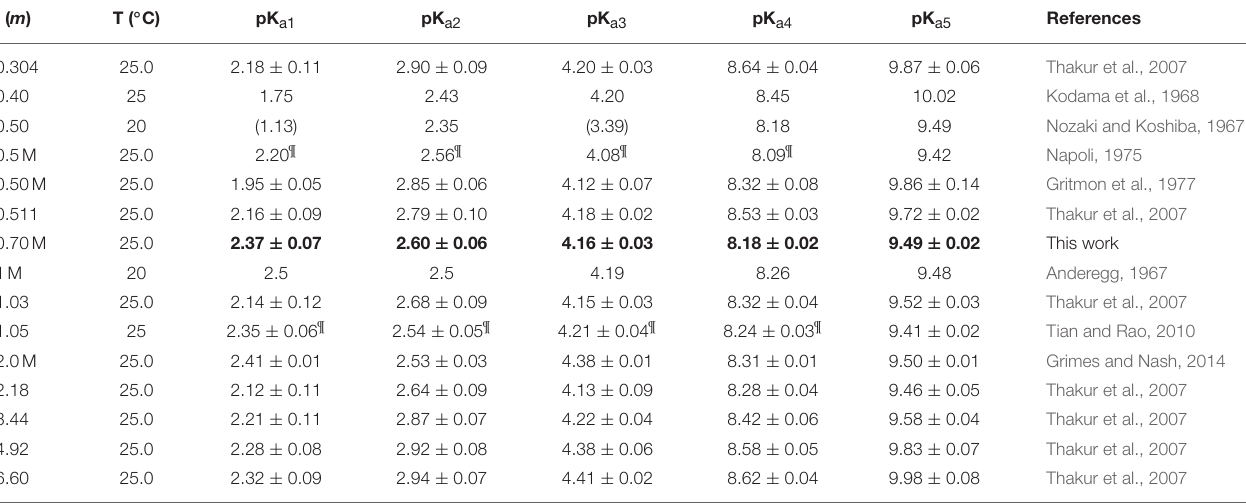
TABLE 3 | Literature values for the five highest DTPA acid dissociation constants in NaClO 4 solutions. I ( m